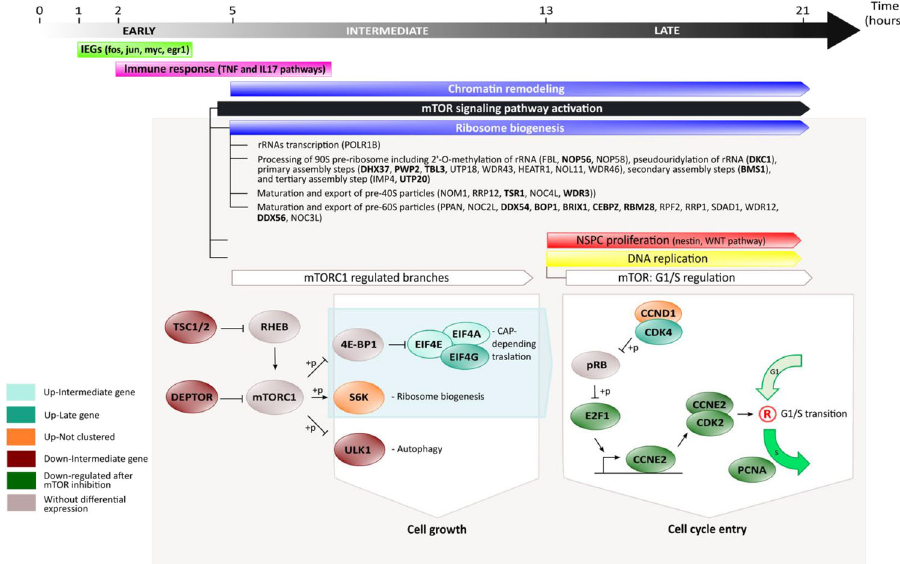
Fig. 8 Summary model of early transcriptional response after SCI in X. laevis . In early modules, around 2 hpT, occur a rapid and transitory activation of IEGs (module E1, green yellow in Figs. 2a and 3) followed by immune response genes (module E2, magenta in Figs. 2b and 3). Posteriorly, in intermediate modules, around 5 hpT, an increase in genes associated with chromatin remodeling is observed (modules I3, blue in Figs. 2e and 3), as well as regulation of several biological events, including activation of mTORC1 (module D1, black in Figs. 2f and 3). Apparently, mTORC1 would act as key regulator over important cellular processes, such as protein synthesis regulation and ribosome biogenesis (module I3, blue in Figs. 2e and 3) observing a strong upregulation of RBFs linked to self-renewal of neuroblast (highlighted in bold), and NSPC proliferation (module L2, red in Figs. 2i and 3) and DNA replication (module L3, yellow in Figs. 2j and 3) in late modules, regulating the G1/S